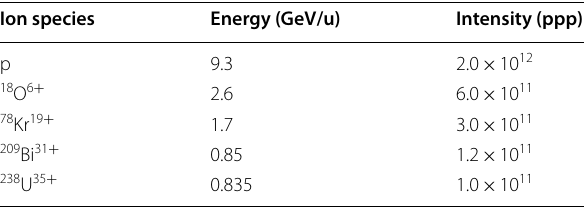
Table 1 Typical beams from the booster. The beam intensities are given in the unit of particles per pulse